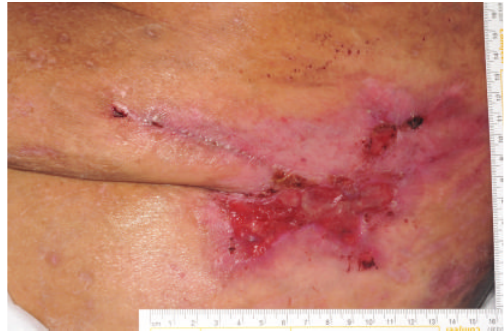
Figure 1: CUA lesion on the lateral abdominal wall with early ulceration, surrounding erythema and induration.